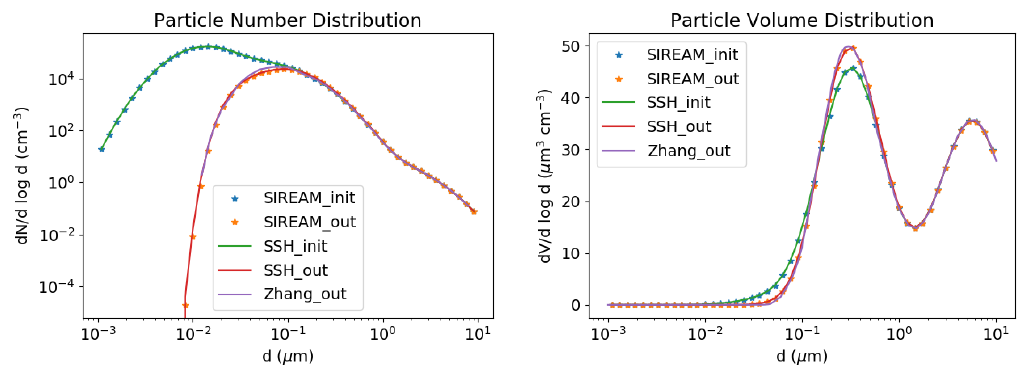
Figure 1. Coagulation test case. Number ( left ) and volume ( right ) concentrations as a function of particle diameter. Initial concentrations are in green and concentrations after 12 h of simulation are in red. The concentrations simulated with SIREAM are plotted with orange stars and those simulated by Zhang et al. in